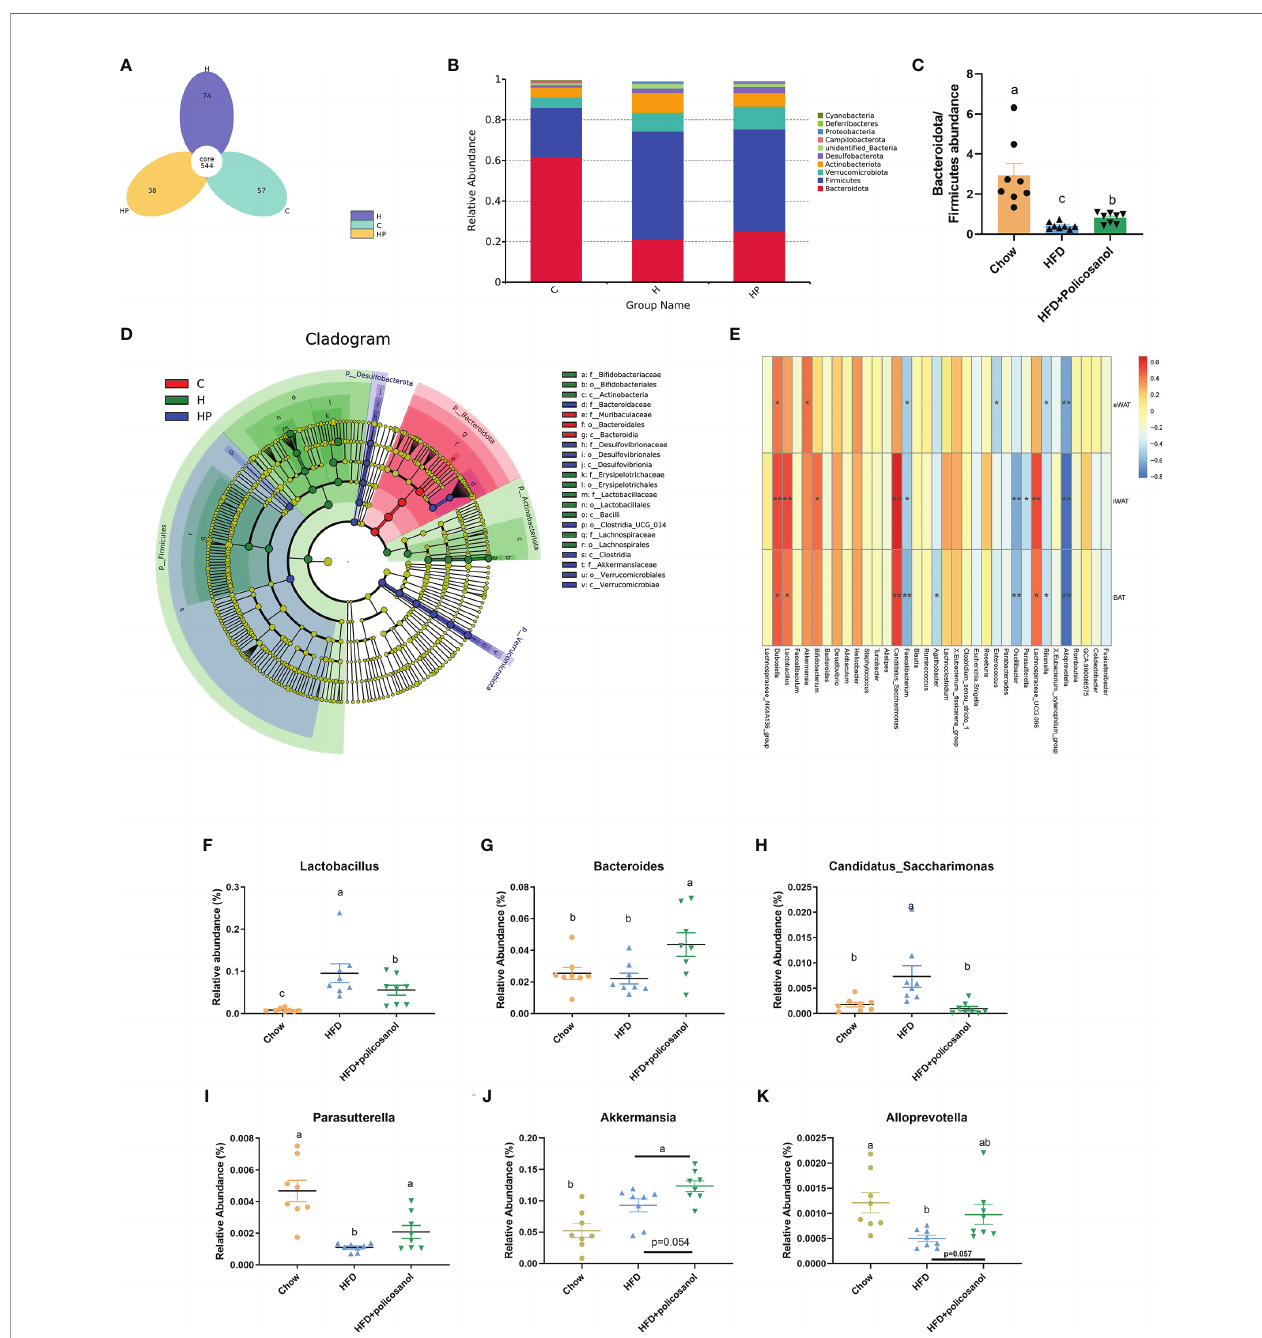
FIGURE 3 | Policosanol reshaped the gut microbiota in mice. (A) The Venn plot of OTUs. (B) Relative abundance of gut microbiota at phylum level. (C) The of Bacteroides / Firmicutes ratio in the cecal contents of mice. (D) LEfse analysis between HFD and HFD+policosanol groups. (E) The correlation among microbiota and adipose tissue weight. ** : | R 2 | > 0.5, *0.4 < | R 2 | < 0.5 (F – K) The key microbiota with signi fi cant difference at genus level. (C) mice fed with chow diet. (H) mice fed with HFD. HP: mice fed with HFD+0.5% policosanol diet, n=8/mice per group. Differences of data in mice subjects were assessed by one-way ANOVA. For all pictures, columns indicated with different letters have signi fi cant difference (a-c), p < 0.05. ns, not signi fi